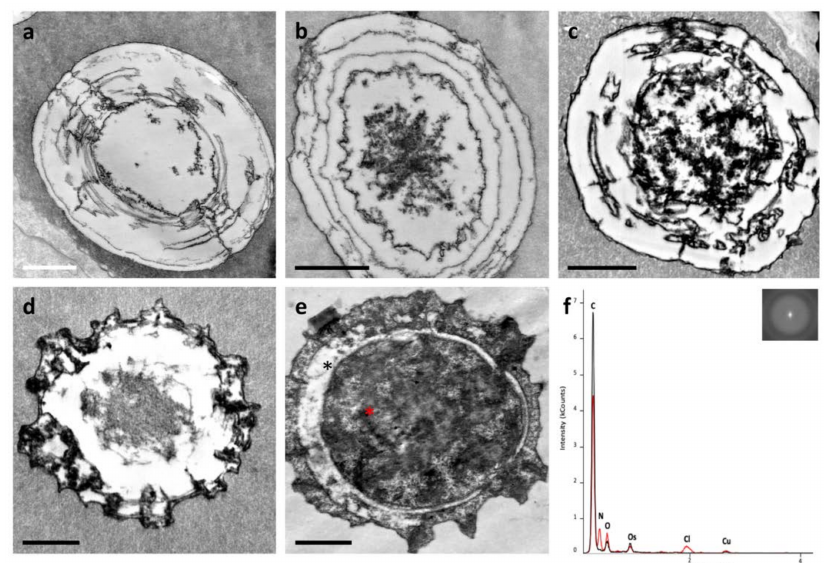
Figure 5. Electron micrography of spheres observed in cells. ( a – c ) Different spheres with regular and smooth contours. ( d , e ) Spheres with contours like a “wagon’s wheel”. ( f ) Energy dispersive spectroscopy (EDS) spectra derived from X-ray microanalysis. The black and red lines were obtained from areas marked with black and red asterisks in ( e ), respectively. Both EDS spectra displayed the peaks of O, C, Os, Cl and Cu, of which the last three derived from the sample preparation. The red line also showed the presence of N. On the top right are selected area electron diffraction patterns obtained in the area marked with a red asterisk in ( e ). Scale bar = 1 µ